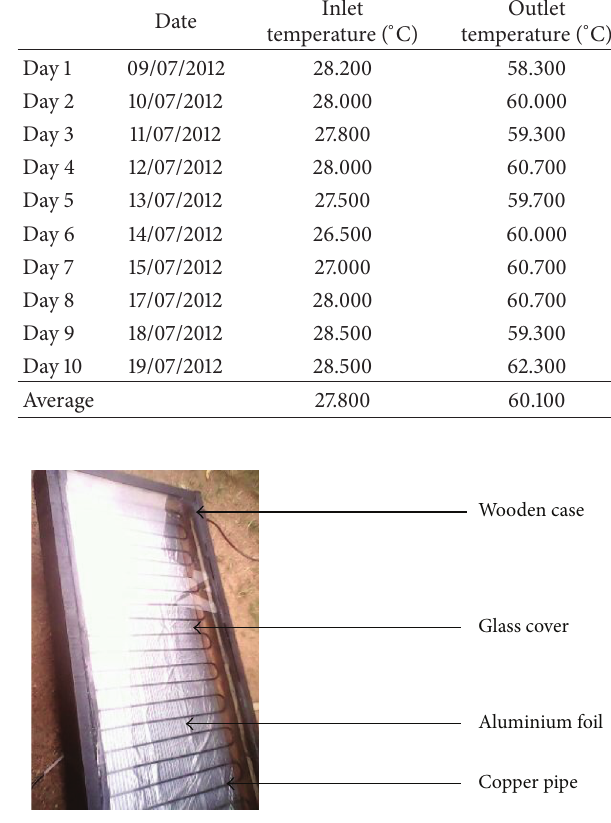
Figure 2: Solar water heating (heat collector)